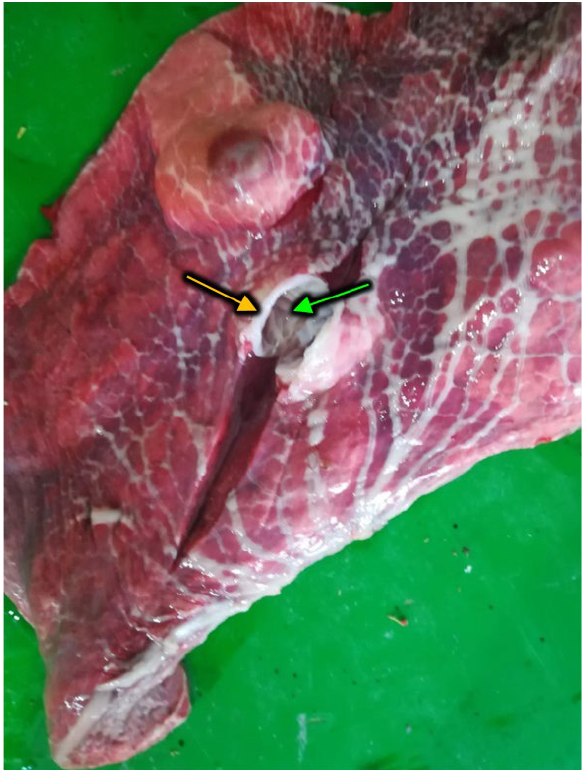
Figure 8. Well-isolated pulmonary hydatid cysts, host derived collagenous layer (connective tissue, yellow arrow) and laminar layer (green arrow) visible on